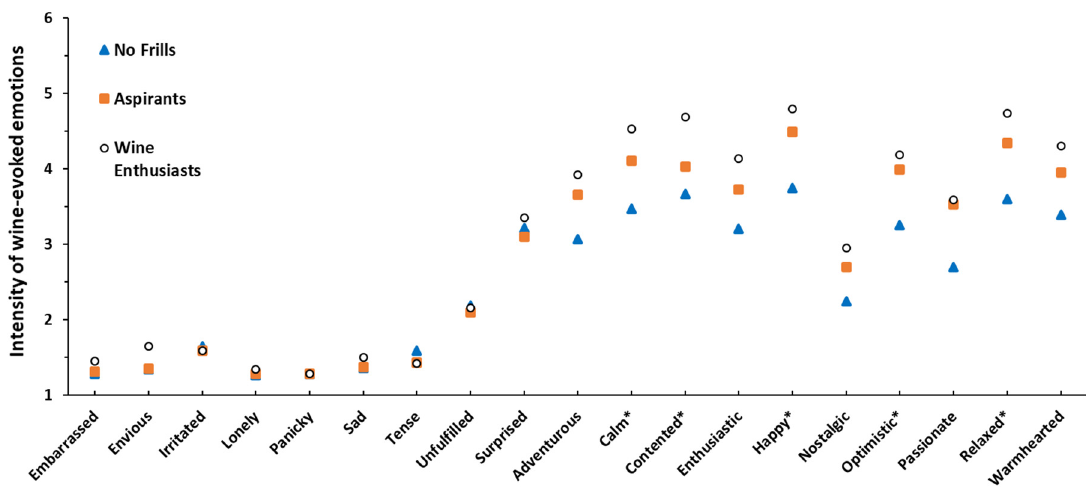
Figure 3. Reported wine evoked emotions for the 3 fine wine segments (FWS), pooled for information condition and samples. Emotion intensities were measured on a 9-point scale, ranging from 1 = not at all to 9 = extremely. * indicates significant differences between FWS at p <